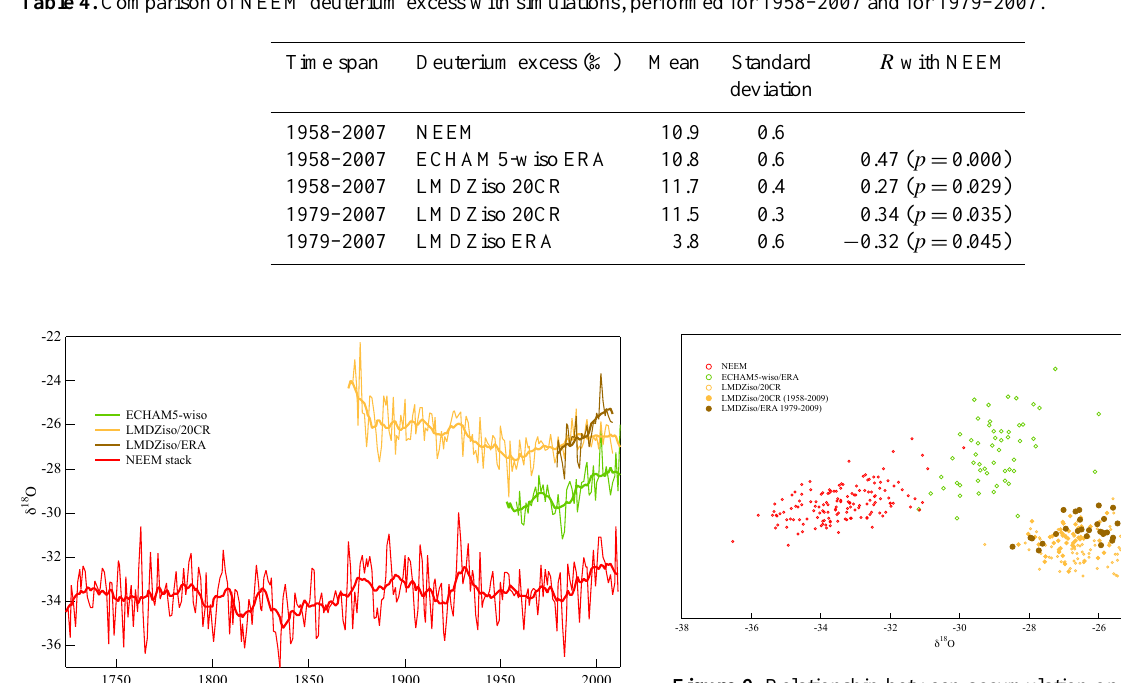
Table 4. Comparison of NEEM deuterium excess with simulations, performed for 1958–2007 and for 1979–2007.